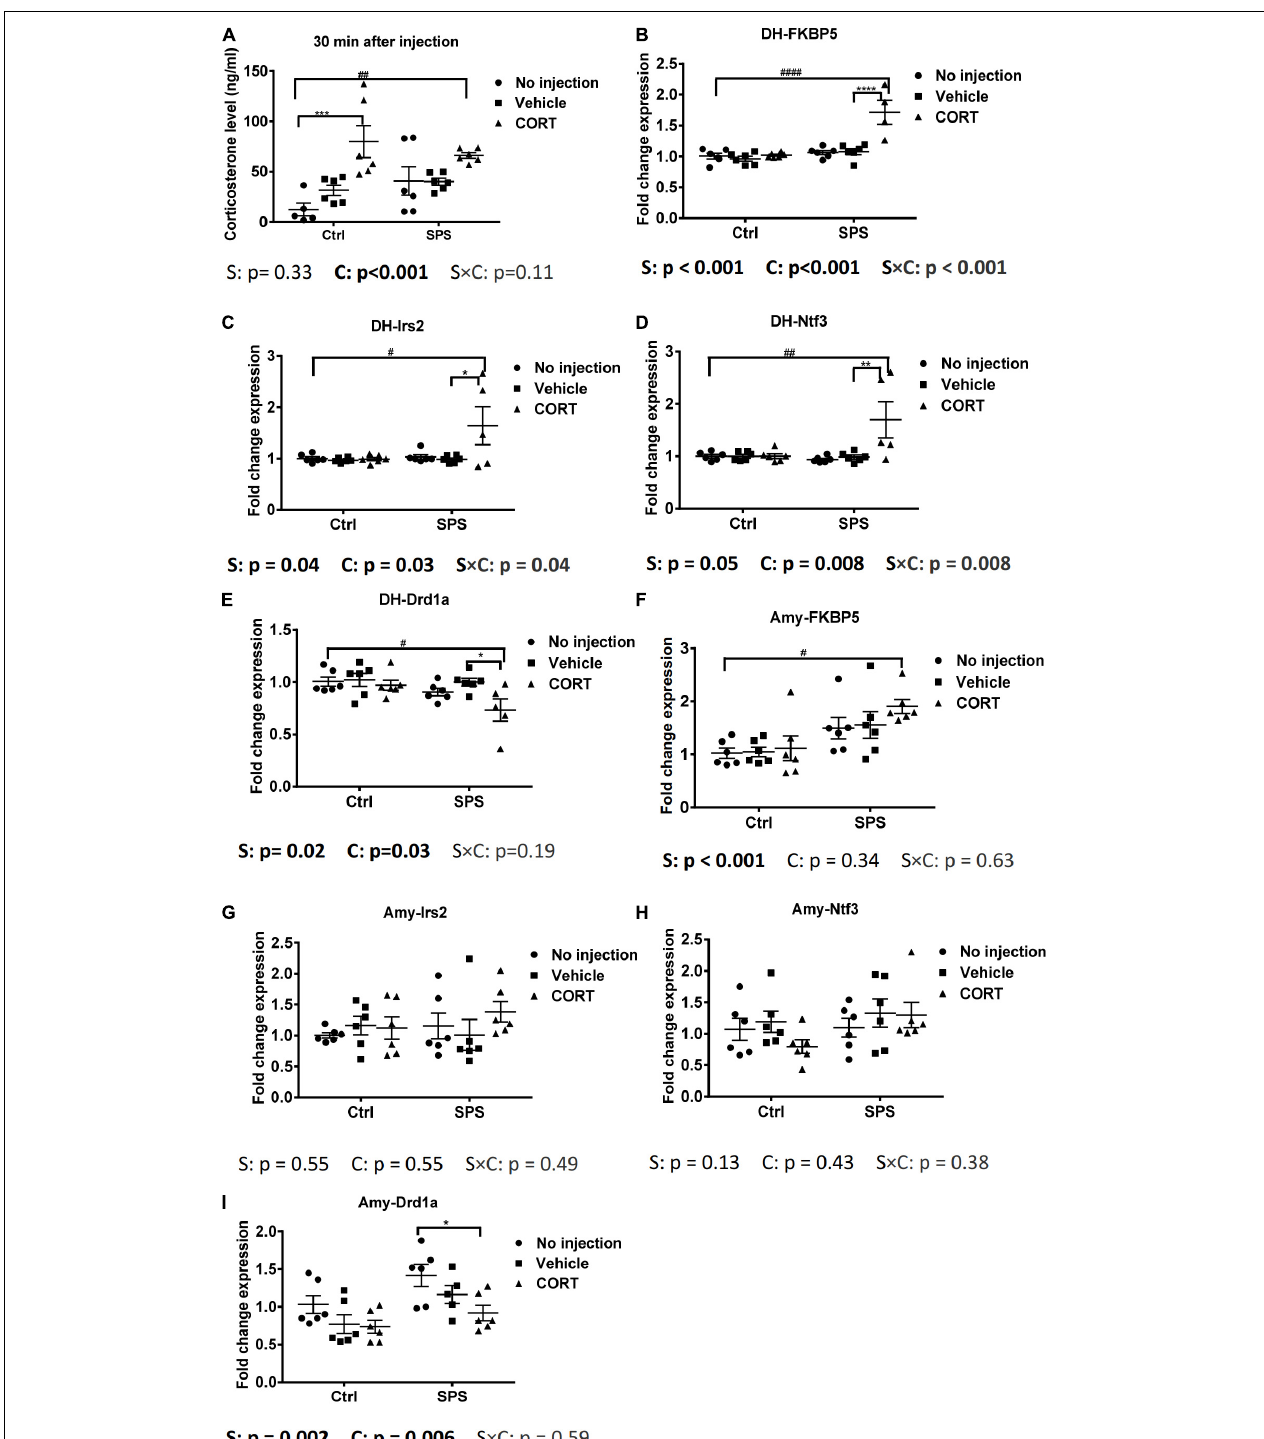
FIGURE 3 | Plasma corticosterone levels and gene expression in the dorsal hippocampus and in the amygdala at 0.5 h after injection. (A) Corticosterone levels, (B) FKBP5 mRNA expression in the dorsal hippocampus, (C) Irs2 mRNA expression in the dorsal hippocampus, (D) Ntf3 mRNA expression in the dorsal hippocampus, (E) Drd1a mRNA expression in the dorsal hippocampus, (F) FKBP5 mRNA expression in the amygdala, (G) Irs2 mRNA expression in the amygdala, (H) Ntf3 mRNA expression in the amygdala, and (I) Drd1a mRNA expression in the amygdala. The data are expressed as mean ± SEM. Statistical significance was determined by two-way ANOVA followed by the post hoc Tukey’s test. #: differences between control and SPS groups; *: differences within the control or SPS groups. p < 0.05, ## p < 0.01, #### p < 0.001, */ # p < 0.05, **/ ## p < 0.01, *** p < 0.001, ****/ #### p < 0.001.